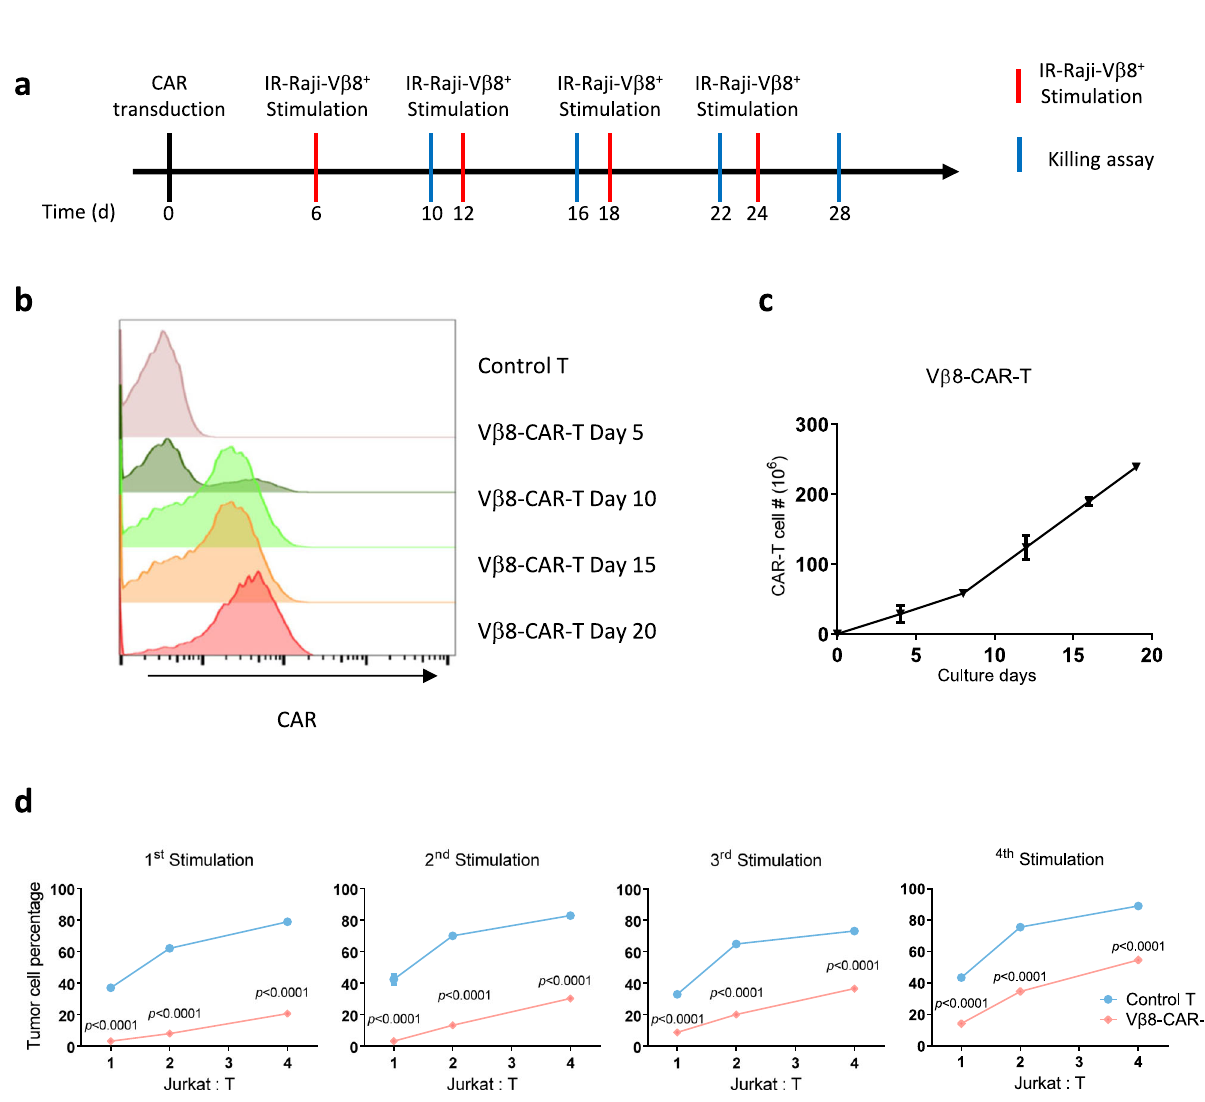
Fig. 3 | Characterization of V β 8-CAR-T cells after repetitive antigen